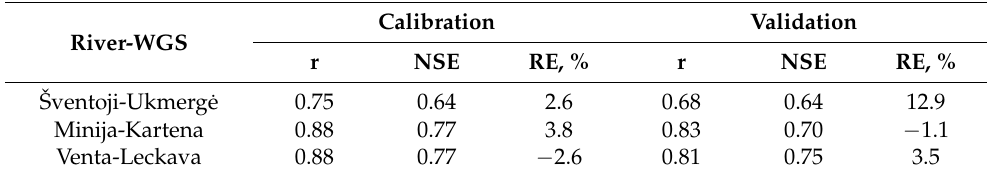
Table 3. Results of calibration and validation of hydrological models (where NSE is Nash–Sutcliffe model efficiency coefficient: RE is a difference between observed and modeled runoff in